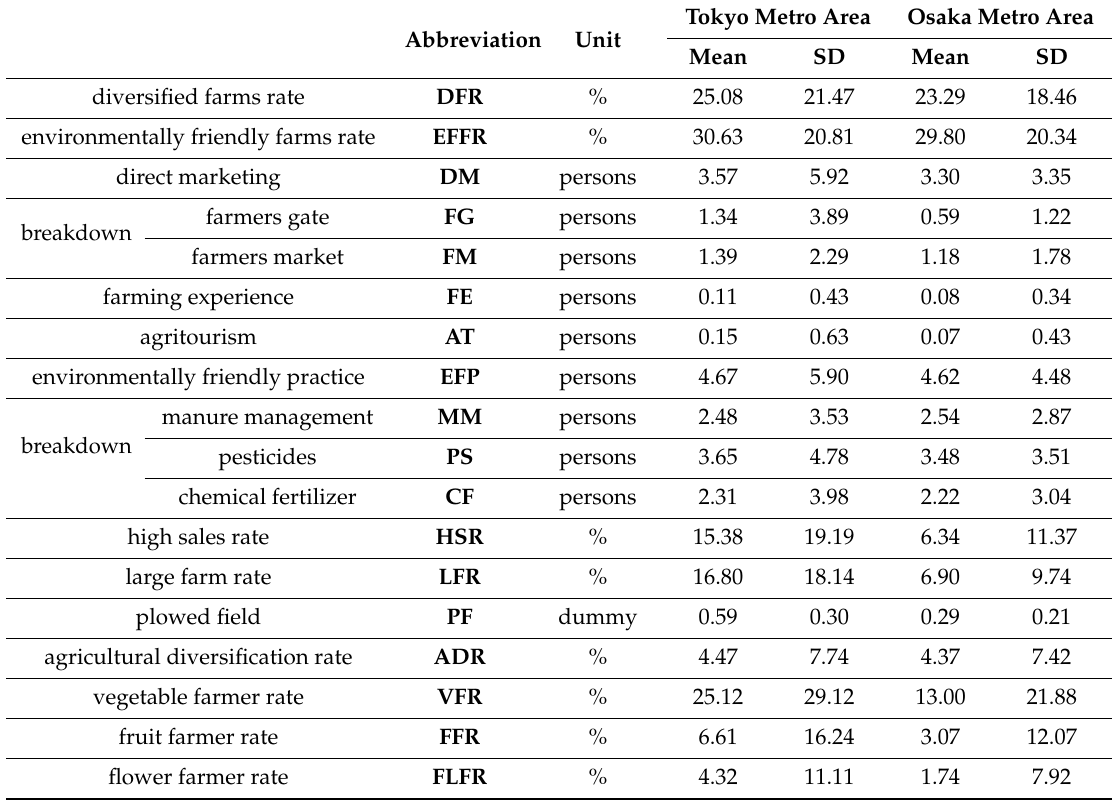
Table 5. Descriptive statistics of agricultural